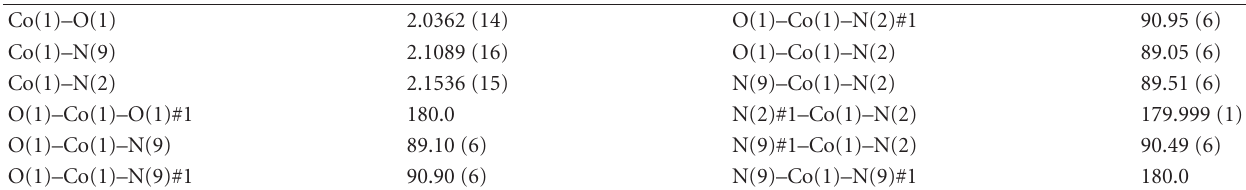
Table 2: Bond lengths [ ˚A] and angles [ ◦ ] for 1 .